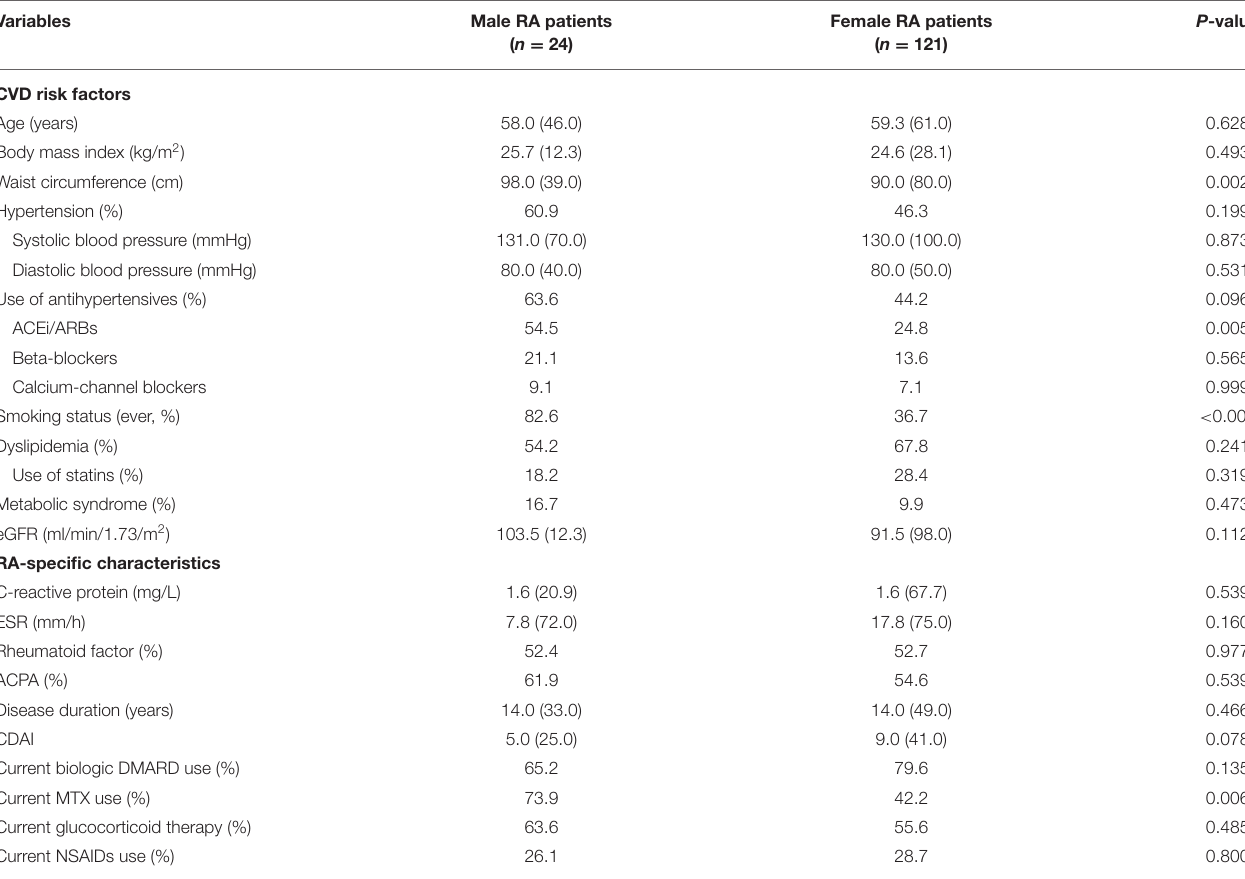
TABLE 1 | Baseline characteristics of RA patients according to